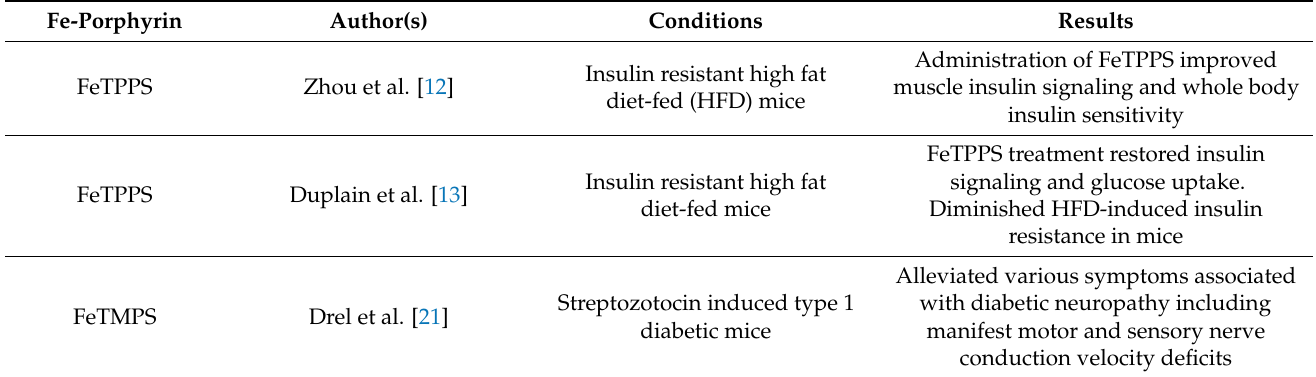
Table 1. Effects of Fe-porphyrin treatment in insulin resistant or diabetic